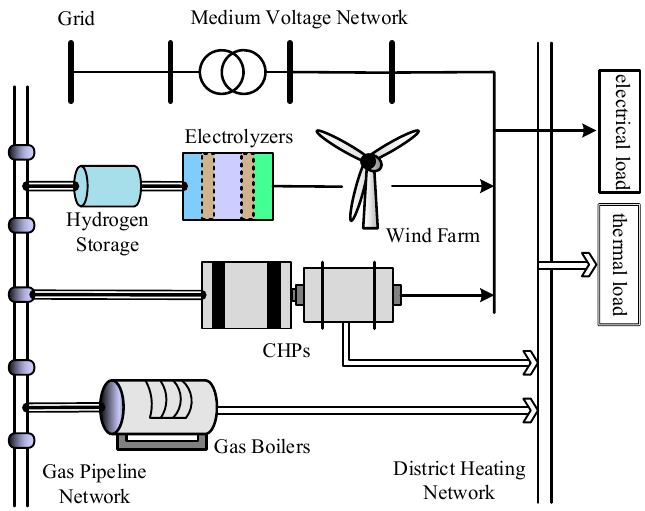
Figure 2. The architecture diagram of combined power-heat system with power to gas (P2G) function.